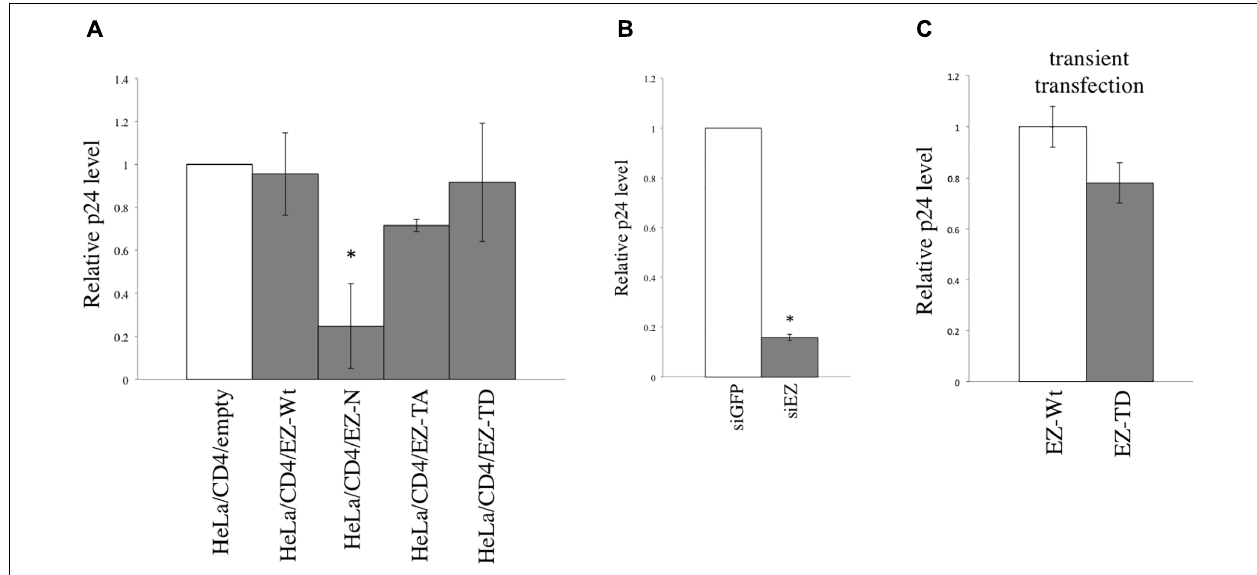
FIGURE 6 | EZ-N and ezrin silencing inhibit HIV-1 replication. (A) HIV-1 NL4-3 was inoculated in HeLa/CD4 cells stably expressing EZ-Wt, -N, -TA, -or TD. (B) HeLa/CD4 cells were transfected with siGFP or siEZ and then inoculated with HIV-1 NL4-3. Gag p24 concentrations in culture supernatants were measured. p24 levels from the empty vector-transduced cells were always set to 1, and relative values of p24 levels are indicated. Error bars show standard deviations, and asterisks indicate statistically significant differences compared to the values of the empty vector-transduced cells. (C) HeLa/CD4 cells were transfected by EZ-Wt or EZ-TD expression plasmid, and were inoculated with replication-competent HIV-1 24 h after the transfection. The p24 levels in culture supernatants were analyzed 3 days after the